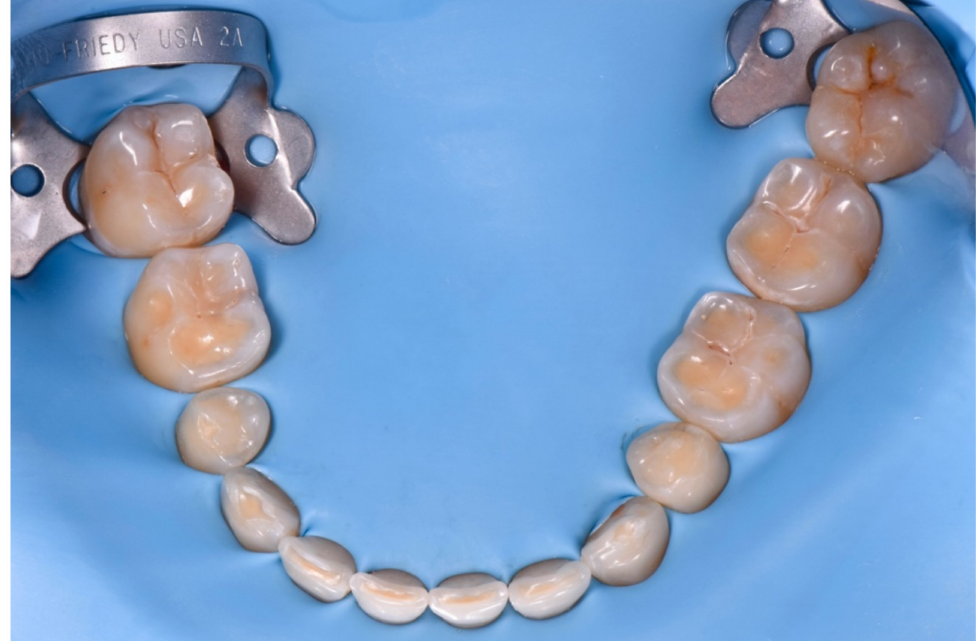
Figure 18. Full arch isolation with rubber